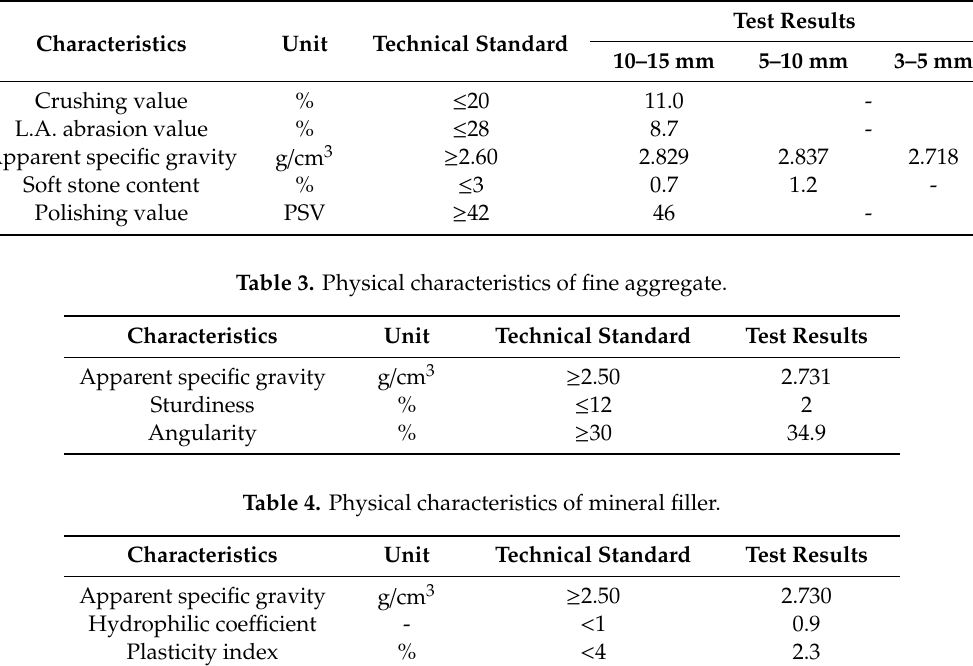
Table 2. Physical characteristics of the coarse aggregates.